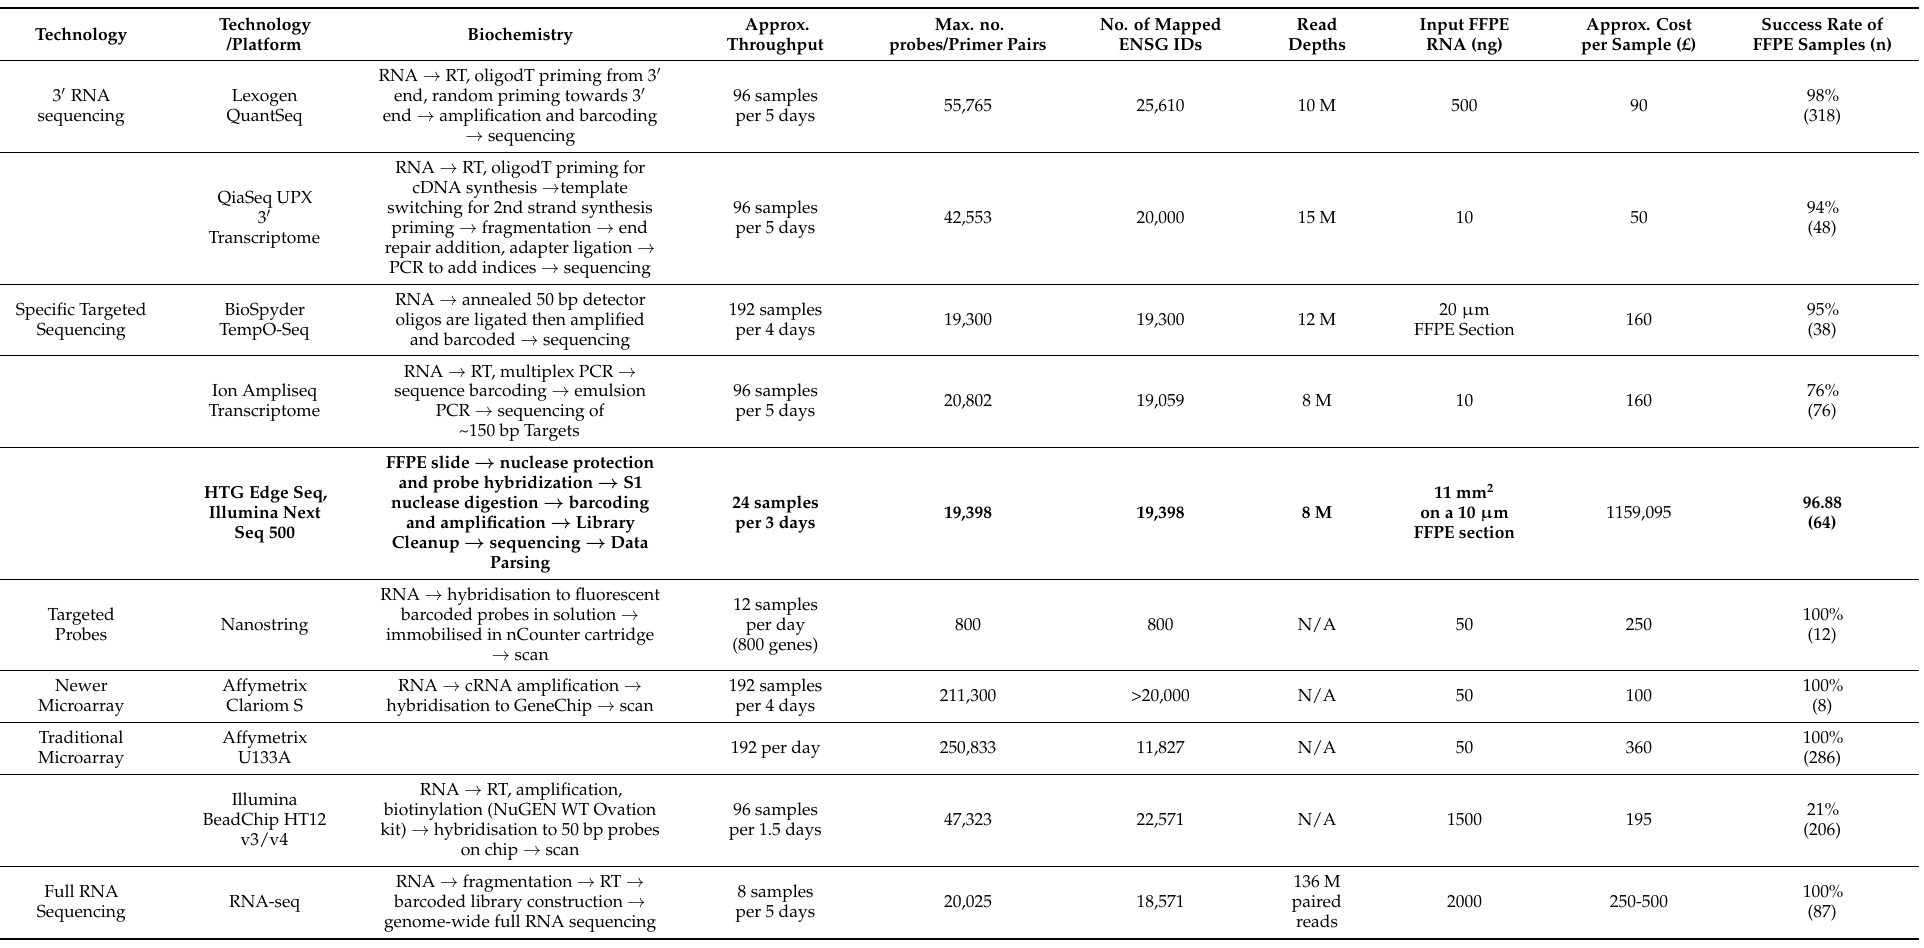
Table 3. Table of technology parameters from the comparison of Turnbull et al. [17], supplemented with parameters of HTP performed in our study (marked in